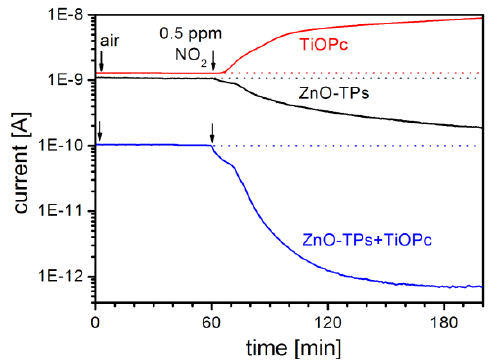
Figure 6. Comparison of the dynamic response of ZnO-TPs, TiOPc, and ZnO-TPs+TiOPc sensors towards 0.5 ppm of NO at room temperature (RH 2